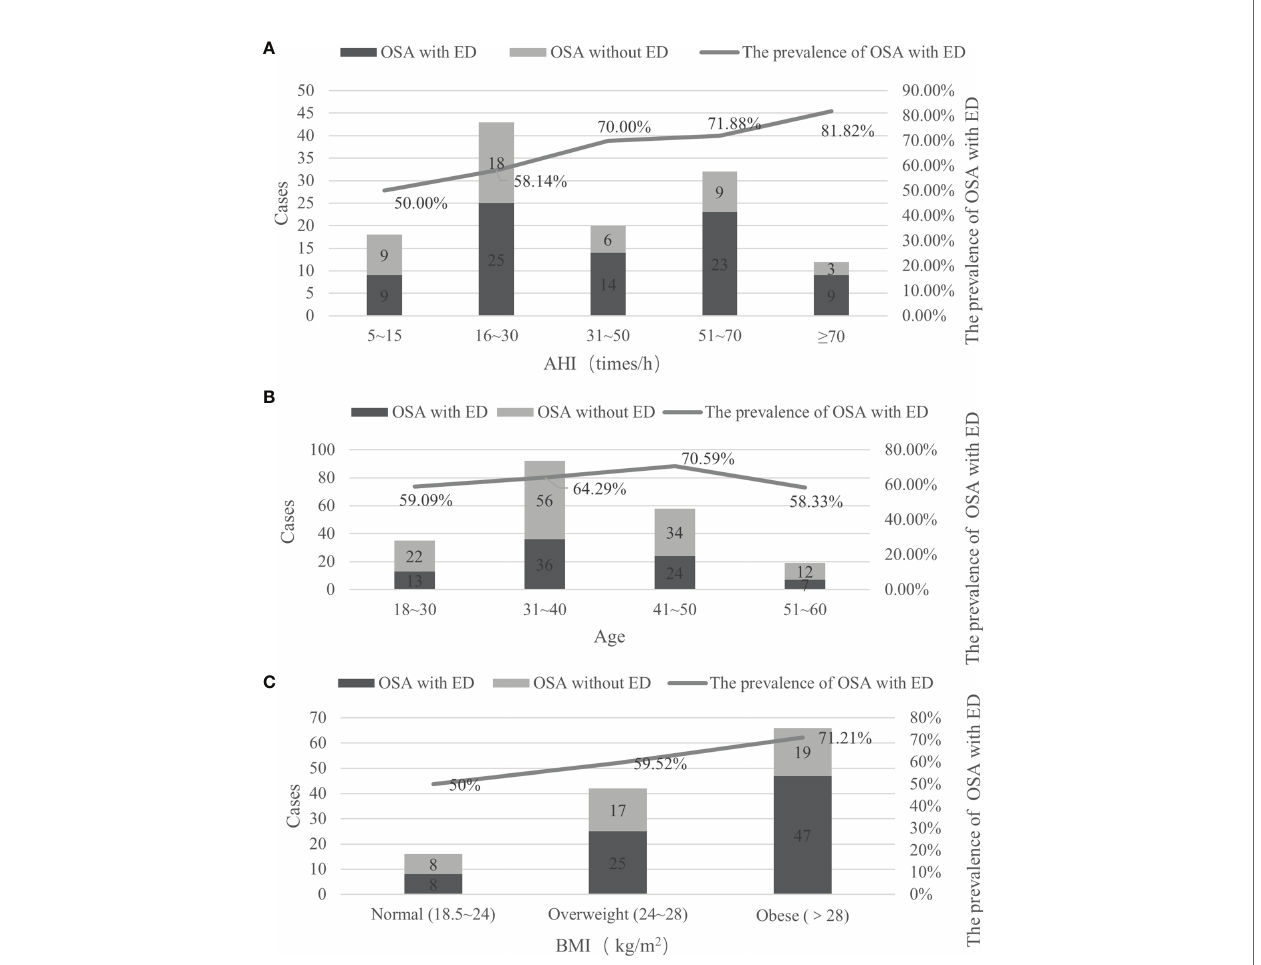
FIGURE 3 | The prevalence of OSA with ED in different AHI, age and BMI groups. (A) It was found that with the increase in AHI values, the prevalence of OSA with ED gradually increased; (B) the prevalence rate gradually increased with age before the age of 50; (C) Among OSA patients, as BMI increased, the prevalence of concurrent ED